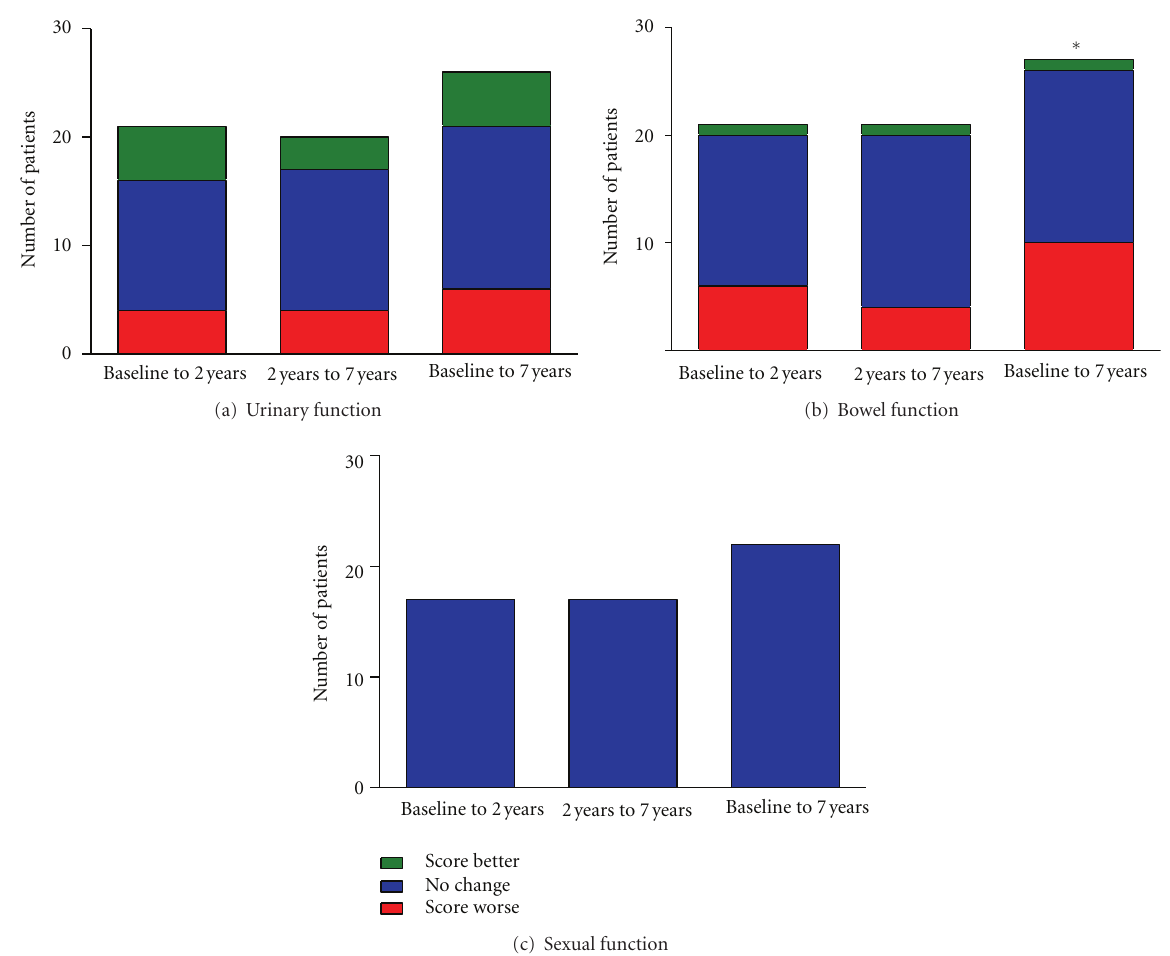
Figure 4: Late e ff ects in normal tissues subjective, objective, management and analytic scales (LENT/SOMA) data. Change in maximum scores per symptom area between nonsignificant scores (score 0,1) and significant scores ( ≥ 2) at baseline, 2-year and 7-year followup (Figure 4(b). Bowel function, ∗ baseline to 7 years P = 0 . 012).